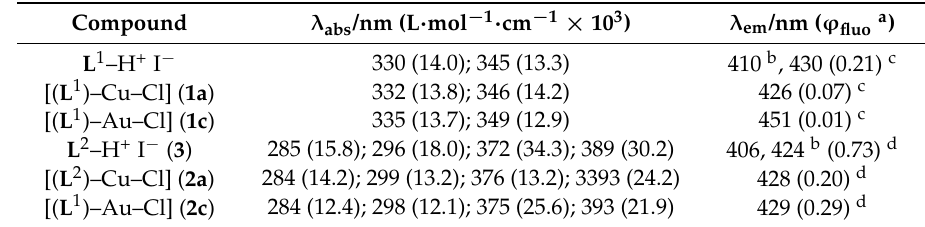
Figure 5. Normalized emission for the azolium salts of L 1 –H + I − , L 2 –H + I − and the carbene metal complexes 1a – 2a and 1c – 2c in CH 2 Cl 2 solution at room temperature.